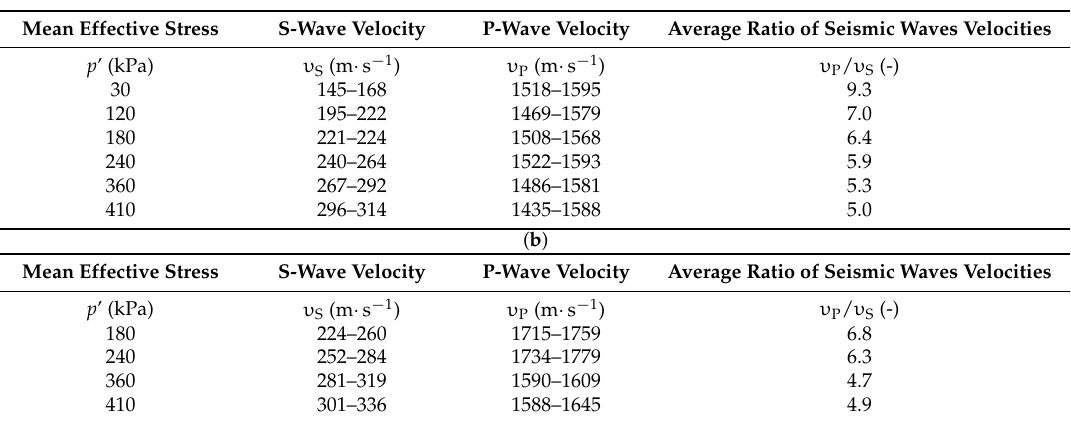
Table 2. Seismic waves velocities for various mean effective stress levels. ( a ) Peak-to-peak method; (b) start-to-start method.